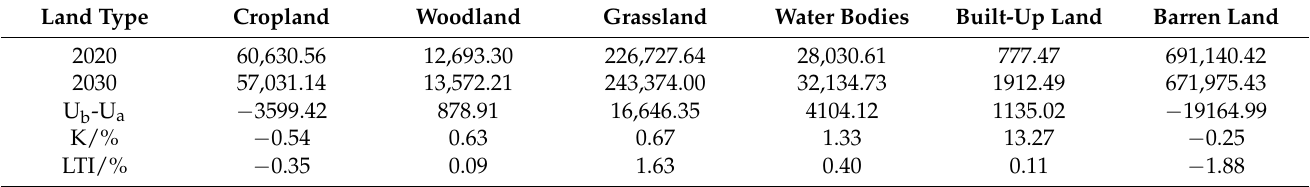
Table 3. Dynamic attitude/intensity analysis of land use in Tarim River Basin during 2020–2030 (km 2